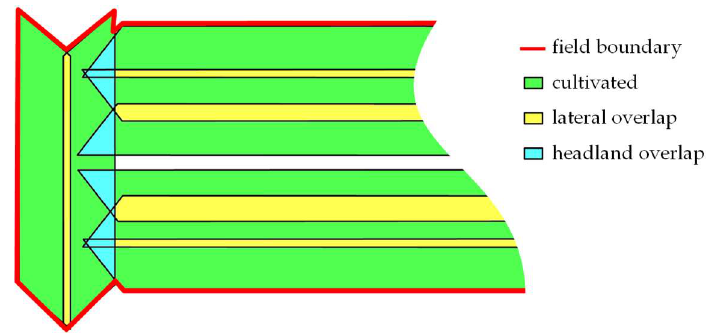
Figure 10. Schematic illustration of the concept of the boundary and overlaps.